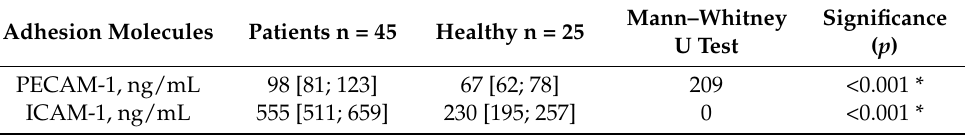
Table 4. Adhesion molecules PECAM-1 and ICAM-1 in the serum of patients following breast cancer treatment and healthy